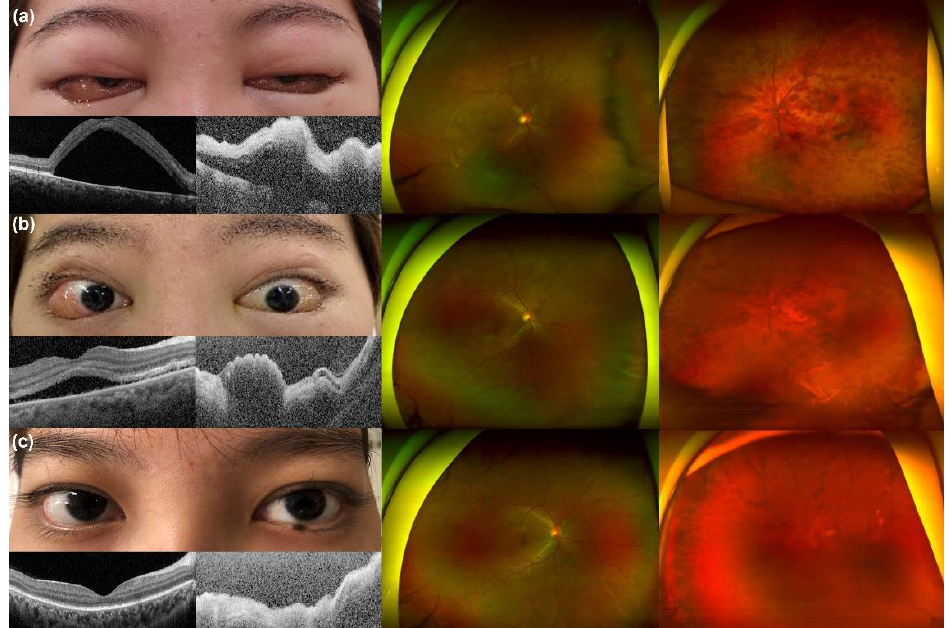
Figure 2. After continued intravenous corticosteroid therapy for one week, ( a ) the bilateral lid swelling and chemosis deteriorated. Moreover, the subretinal fluid (SRF) in the right eye increased. ( b ) One day after the first TPE, the bilateral lid swelling markedly improved, and SRF decreased in the right eye. ( c ) There was a complete resolution of the lid swelling, chemosis, and SRF after the sixth and last TPE.